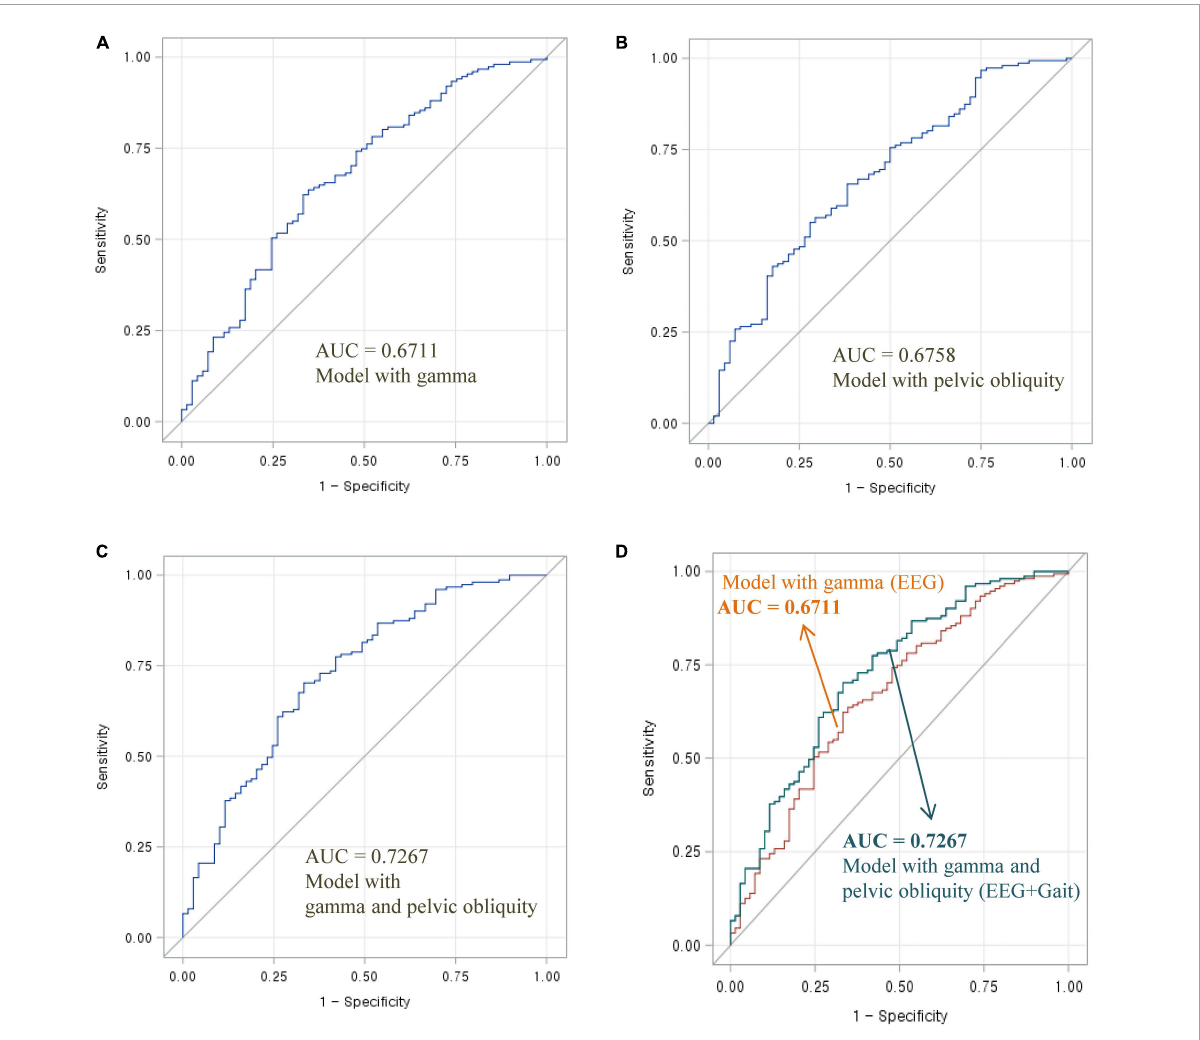
FIGURE2 Area under the ROC curve of EEG and gait parameters for classifying MCI and normal cognition: (A) Model with gamma power, (B) model with pelvic oblique, (C) combined model with gamma power and pelvic oblique, and (D) comparison of AUC